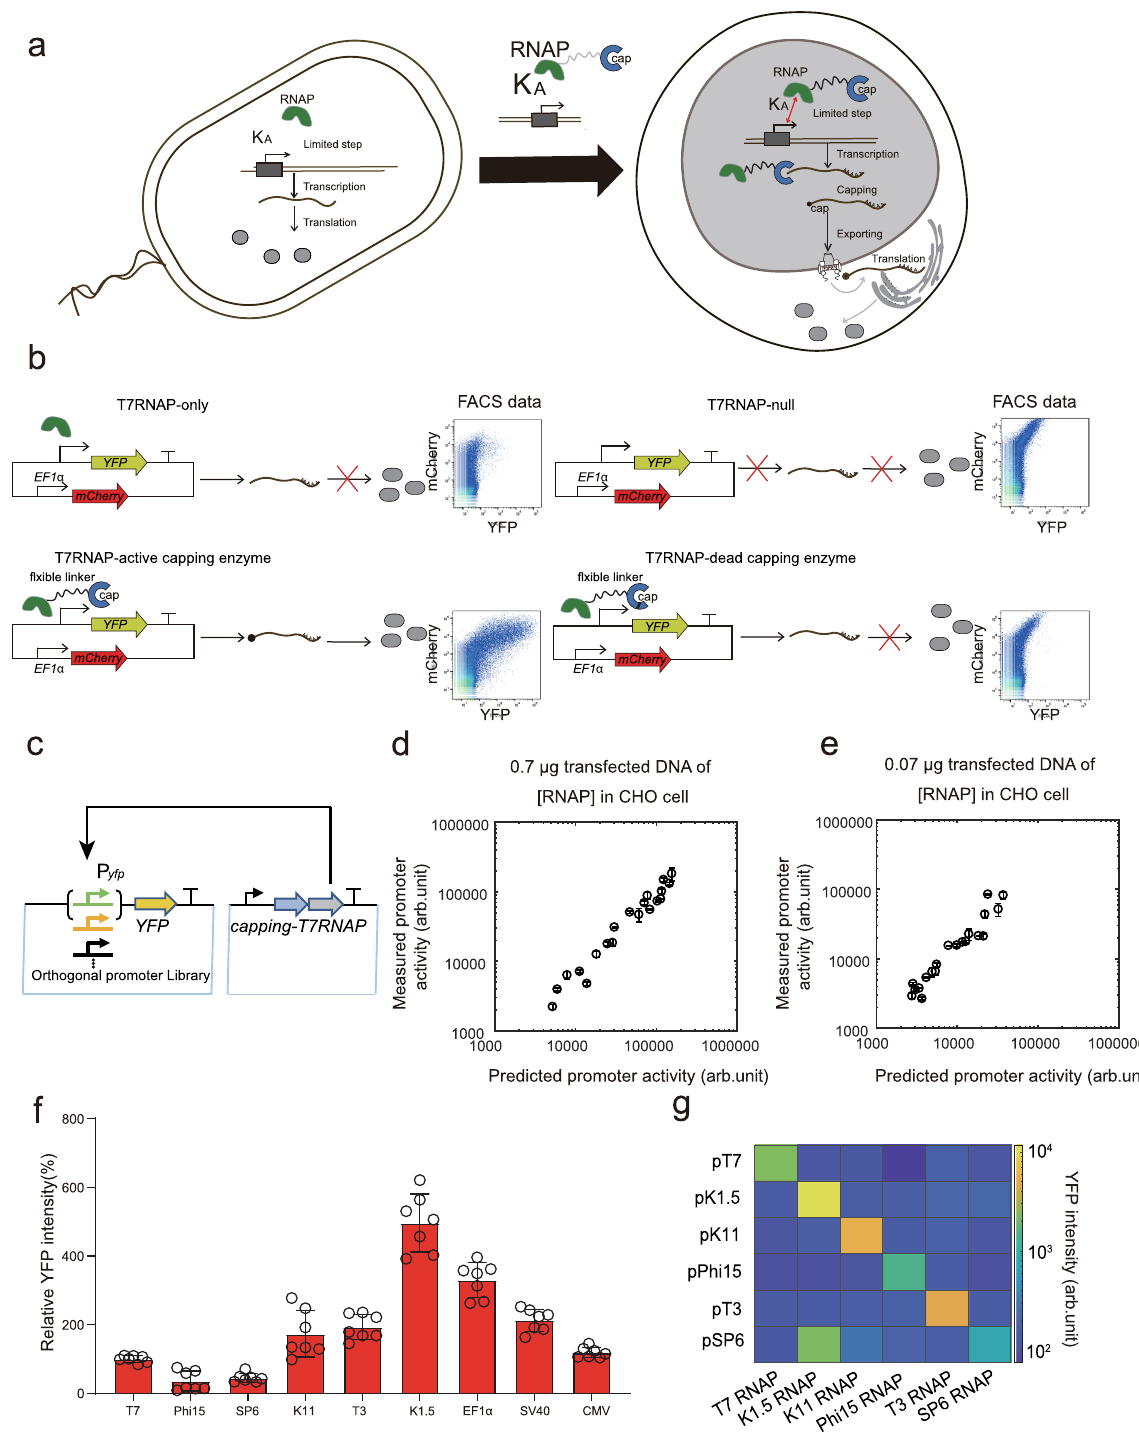
Fig. 1 | Design and characterization of the orthogonal transcription system. a The binding of the orthogonal RNAP to its cognate promoters (with binding af fi nity K A ) is a limiting step for protein synthesis in all organisms. The capping enzyme fused to RNAP ensures nuclear export and translation ef fi ciency of the synthetic transcripts in mammalian cells. b The reporter gene expressions for the T7 promoter with RNAP-null, RNAP-only, RNAP-dead capping enzyme and RNAP- active capping enzyme. c Scheme of the quantitative measurement circuit com- posed of a monomeric RNA polymerase (RNAP) fused to a capping enzyme driven bytheEF1 α promoterandasetof T7promotervariantsintwoseparatedplasmids. d Linearity between expression measured by fl ow cytometry and expression